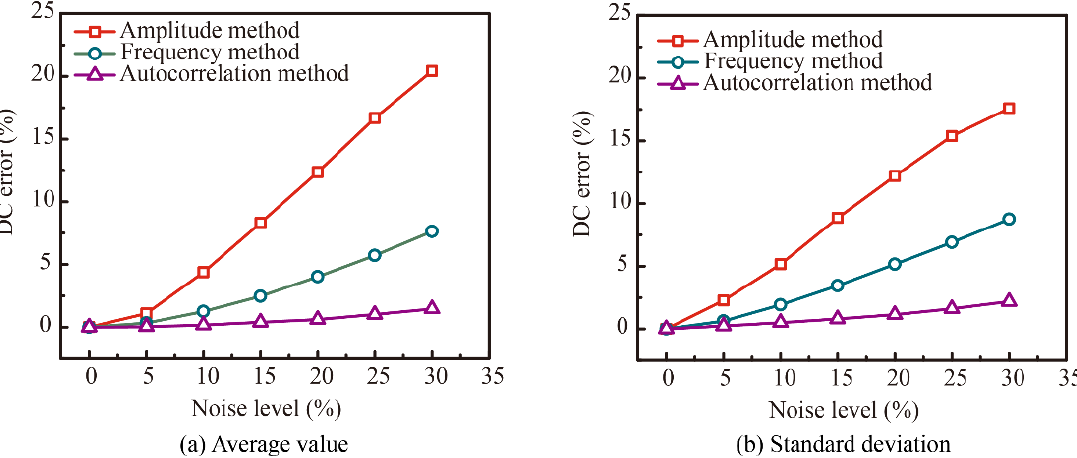
Figure 5. For pure tensile cracks, the inversion errors for different noise levels. Line types represent the results of the three inversion methods: Amplitude, frequency, and autocorrelation methods. The autocorrelation method represents the inversion method based on the new correlation function of raw waveforms for simplicity.